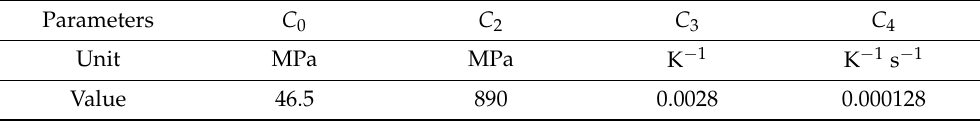
Table 7. Parameters of the ZA model for an FCC material (copper) (